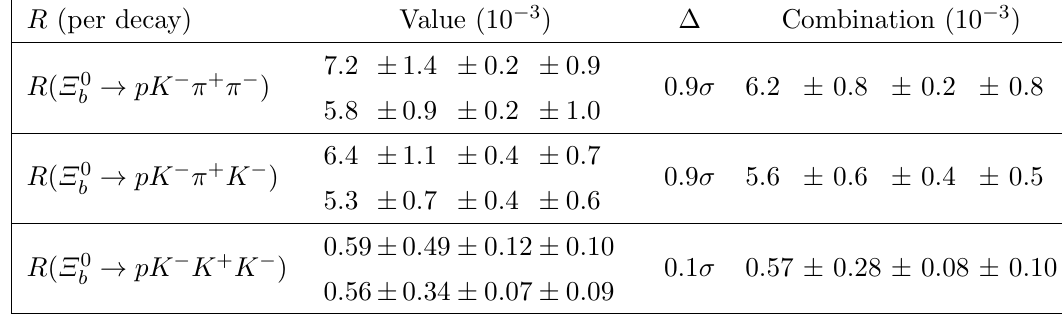
Table 6 . Measurements of the R ratio from the ((cid:12)rst row) 2011 and the (second row) 2012 data samples for (cid:4) 0 decay modes expressed in per mil as well as their combination. The three uncer- b tainties are statistical, systematic related to the (cid:12)t model and systematic related to the e(cid:14)ciency, respectively. The consistency of the two determinations for each year, denoted (cid:1), is quanti(cid:12)ed as the ratio of the signed di(cid:11)erence of the central values over the quadratic sum of the related